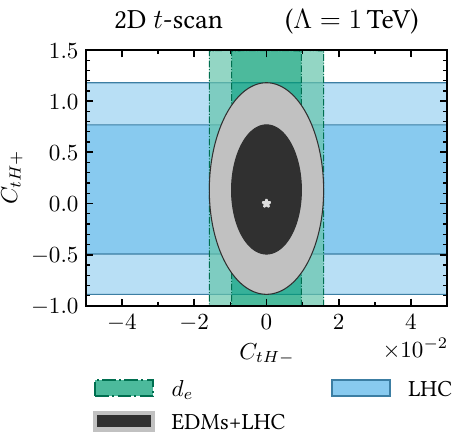
Figure 5 . Magnification of the lower left plot of figure 4 showing the constraints on CP-even and CP-odd contributions to the top-quark Yukawa ( C tH ±